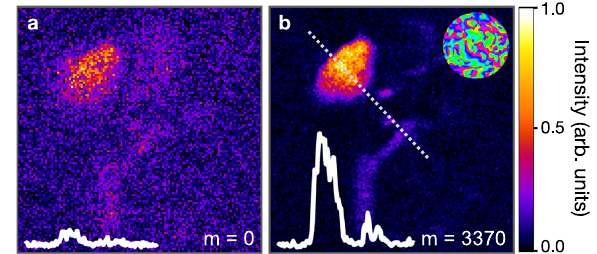
Fig. 4 Deep tissue imaging. TPEF images of a single microglia cell at a depth of 530 μ m in mouse hippocampal tissue before correction ( a ) and with DASH correction after three iterations ( m = 3370) ( b ). Intensity pro fi les extending over 20 μ m along the dashed line are shown as insets, along with the fi nal correction mask and similar results were reproduced fi ve